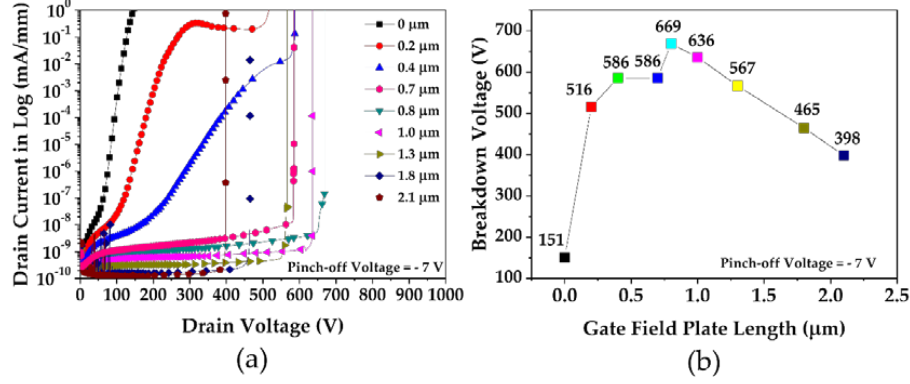
Figure 5. ( a ) Drain leakage current characteristics of AlGaN/GaN HEMT in a log scale and ( b ) breakdown voltage as a function of FP lengths.